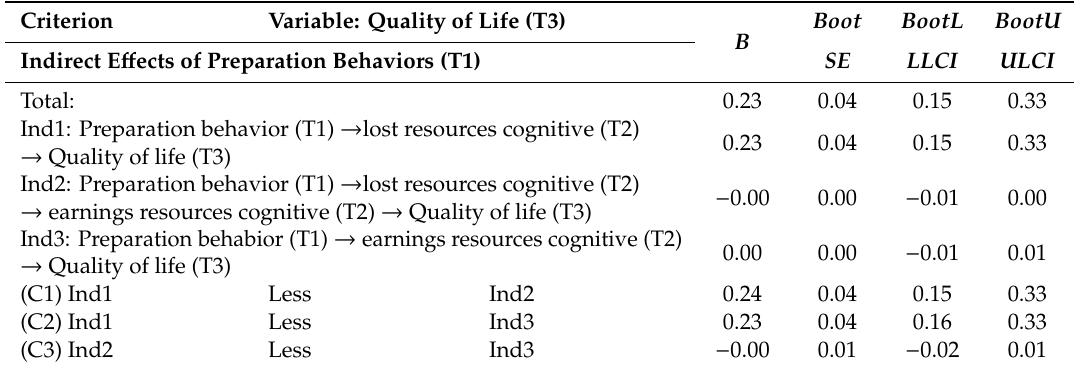
Table 3. Comparison of the indirect effects of preparation behaviors (T1) through the losses (T2) and gains of cognitive resources (T2) in the prediction of quality of life (T3).